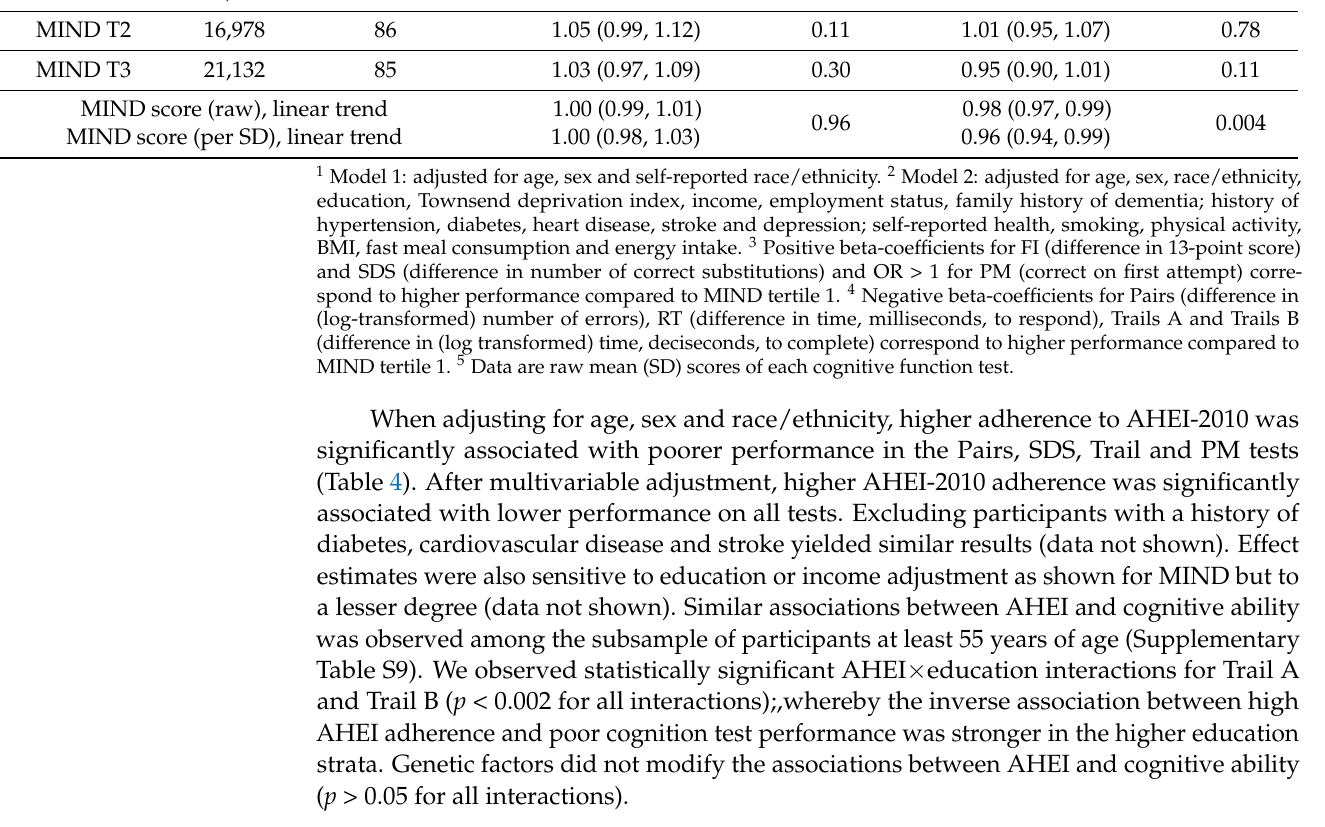
Table 4. Associations between adherence to AHEI-2010 and cognitive